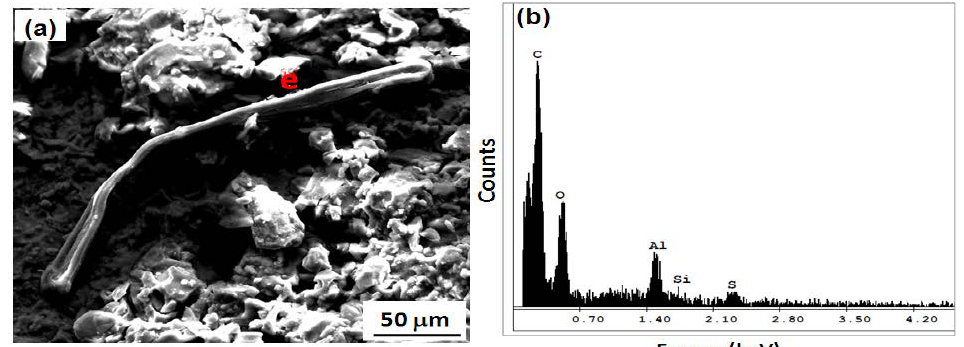
Figure 11: SE SEM image: (a) fibre particle d in damaged portion of the antenna (location A) and (b) EDS pattern corresponding to fibre particle d.